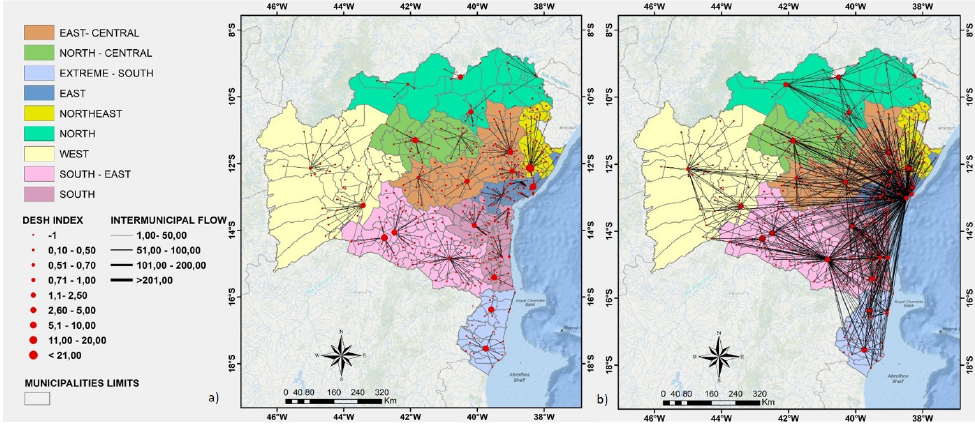
Figure 1. A visual comparison between the expected ( a ) and observed ( b ) hospitalization networks for COVID-19 patients in Bahia, Brazil. Source: Author. Table 1. A numerical overview of the observed hospitalization networks for COVID-19 patients with respect to the nine regions of the state of